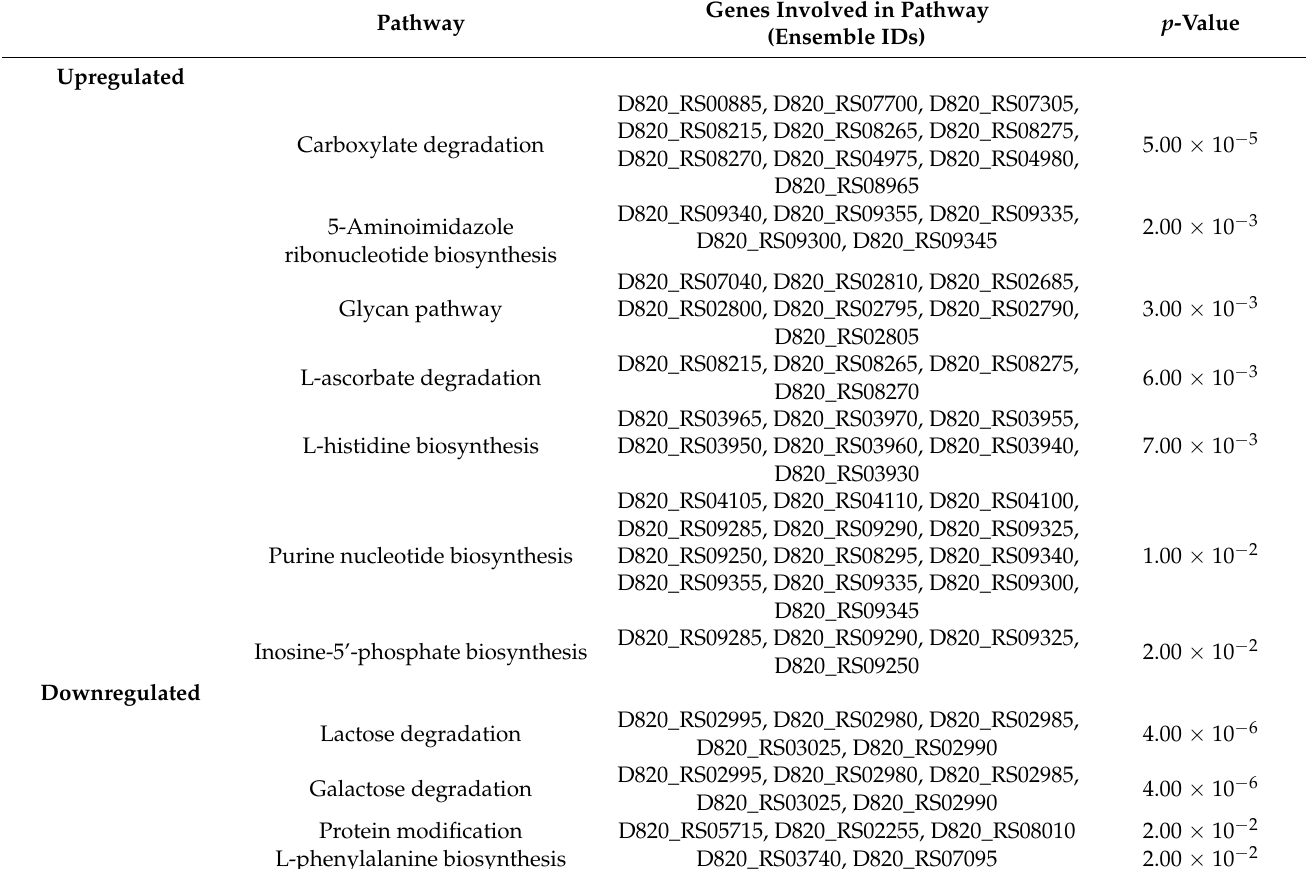
Table 4. Significantly up- and downregulated pathways in S. mutans upon CHX treatment. Pathway